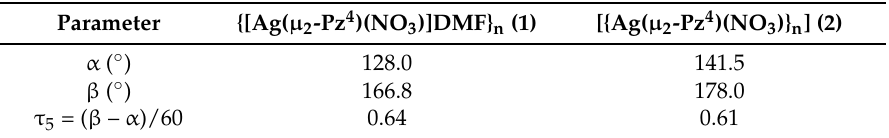
Table 4. Selected bond distances (Å) for the complexes 1 and 2 .